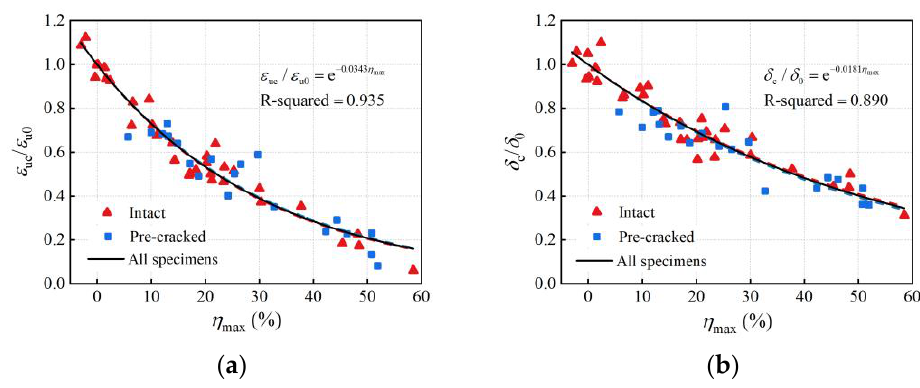
Figure 20. Relationships between ductility indices and maximum cross-section loss: ( a ) ultimate strain; ( b ) elongation after fracture.